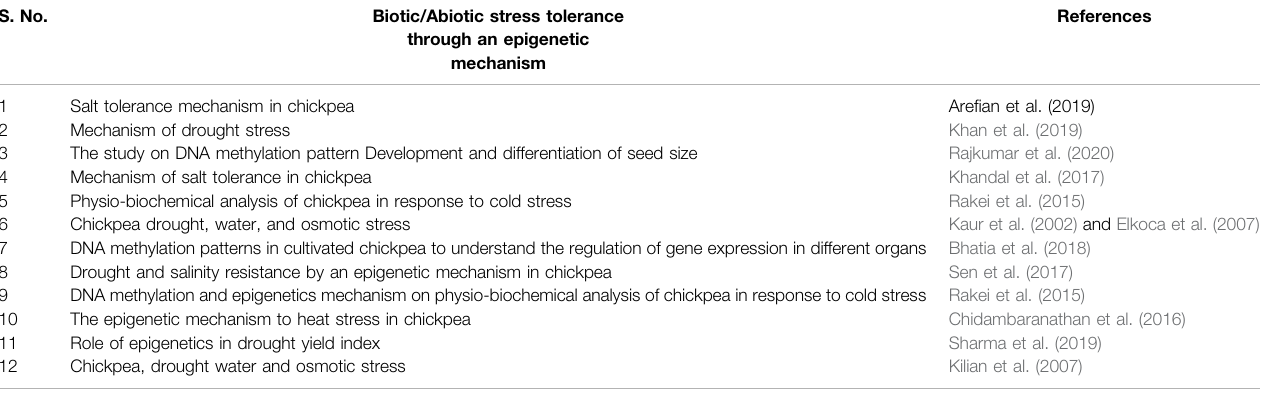
TABLE 4 | Epigenetic studies related to biotic and abiotic stresses in chickpea. S. No.